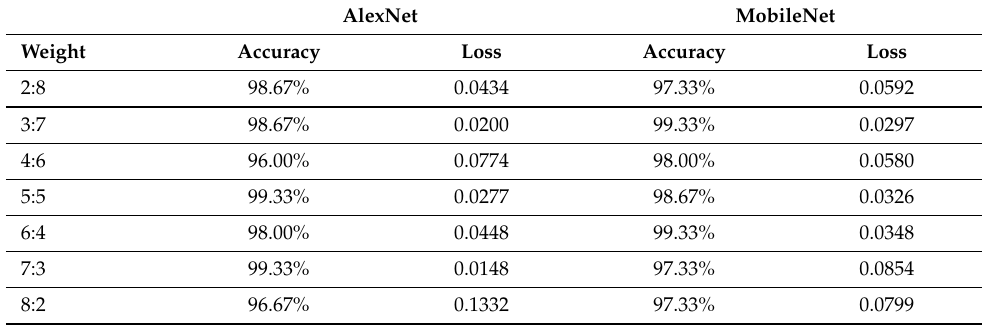
Table 3. The weigh of fusion ratio and training results in AlexNet and MobileNet.